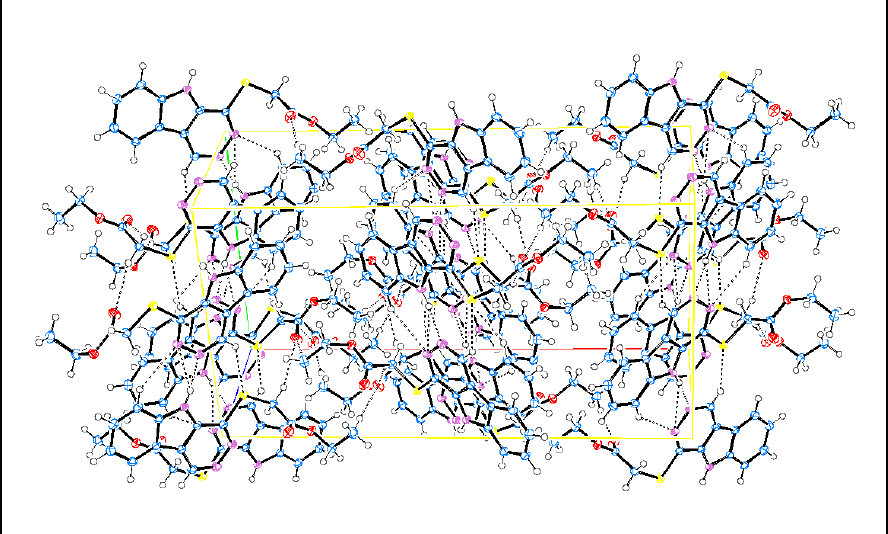
Figure 3. Packing diagram of compound 6 .